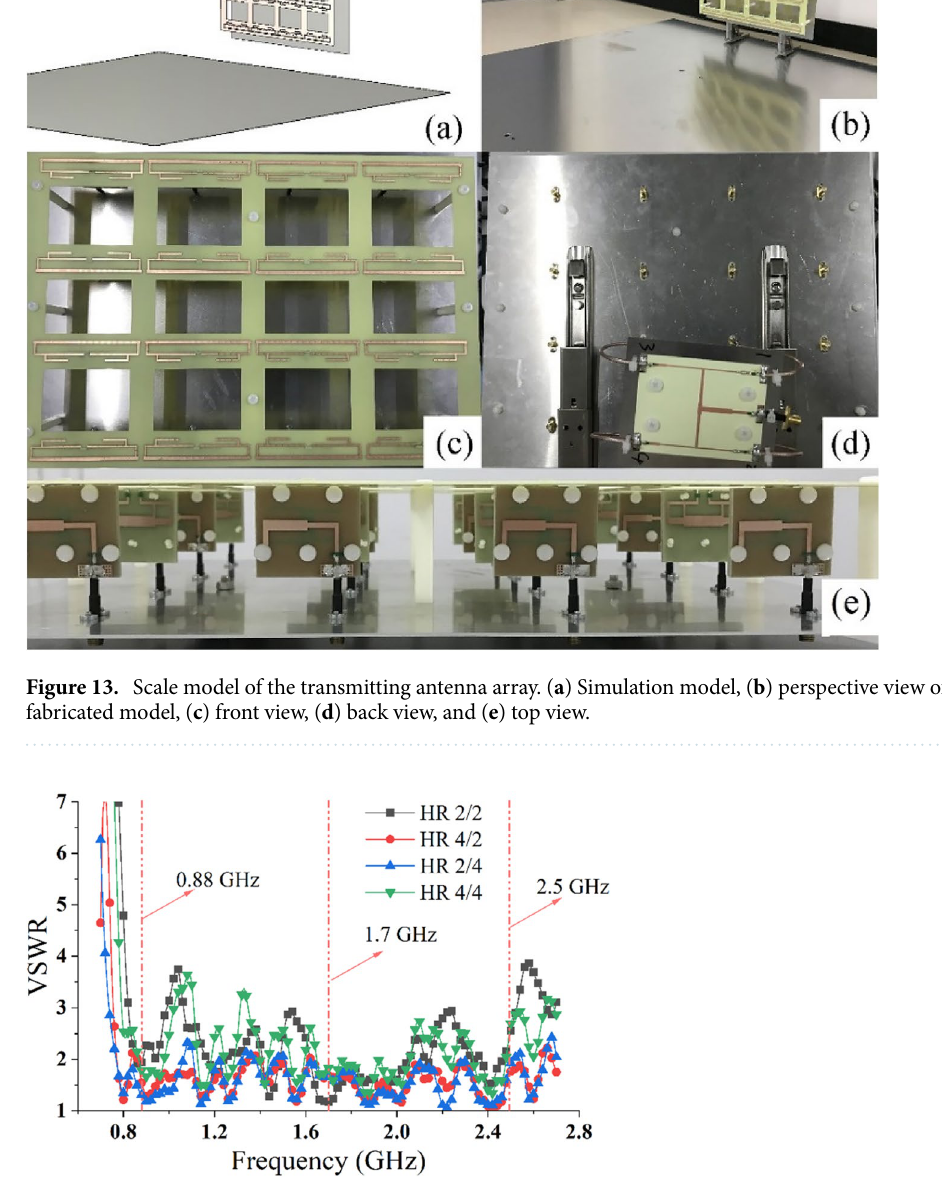
Figure 14. Measured VSWRs of the four